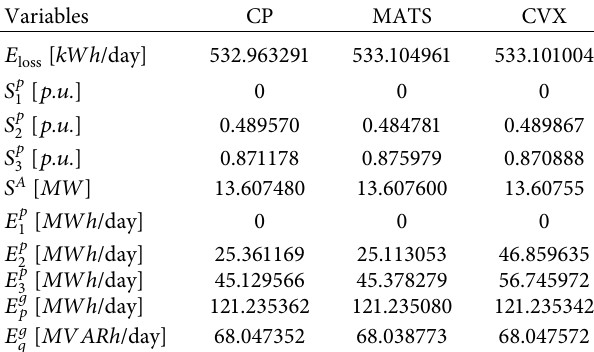
Table 6: Results for simulation